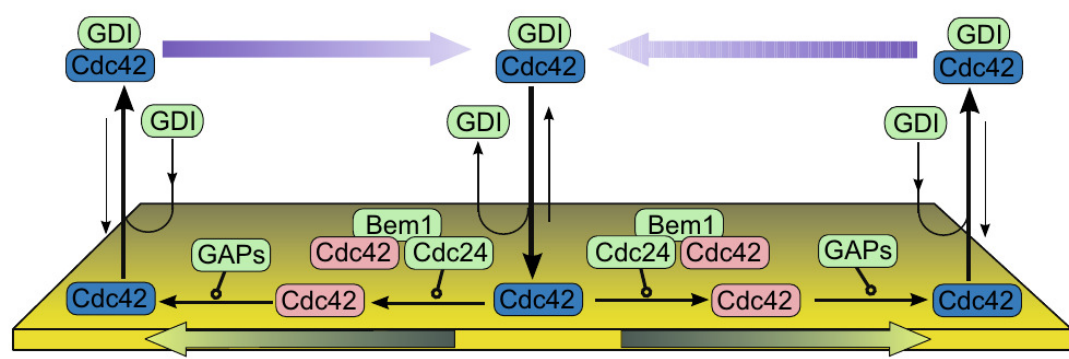
Figure 18. The components of a model for self-organized clustering of activated Cdc42 in yeast. Blue (pink) represents inactive (active) Cdc42 in the cluster. Inactive Cdc42 is activated at the membrane by a complex of active Cdc43, Bem1 and Cdc24. The guanine dissociation inhibitor (GDI) shuttles inactive Cdc42 to and from the membrane. From Goryachev and Pokhilko